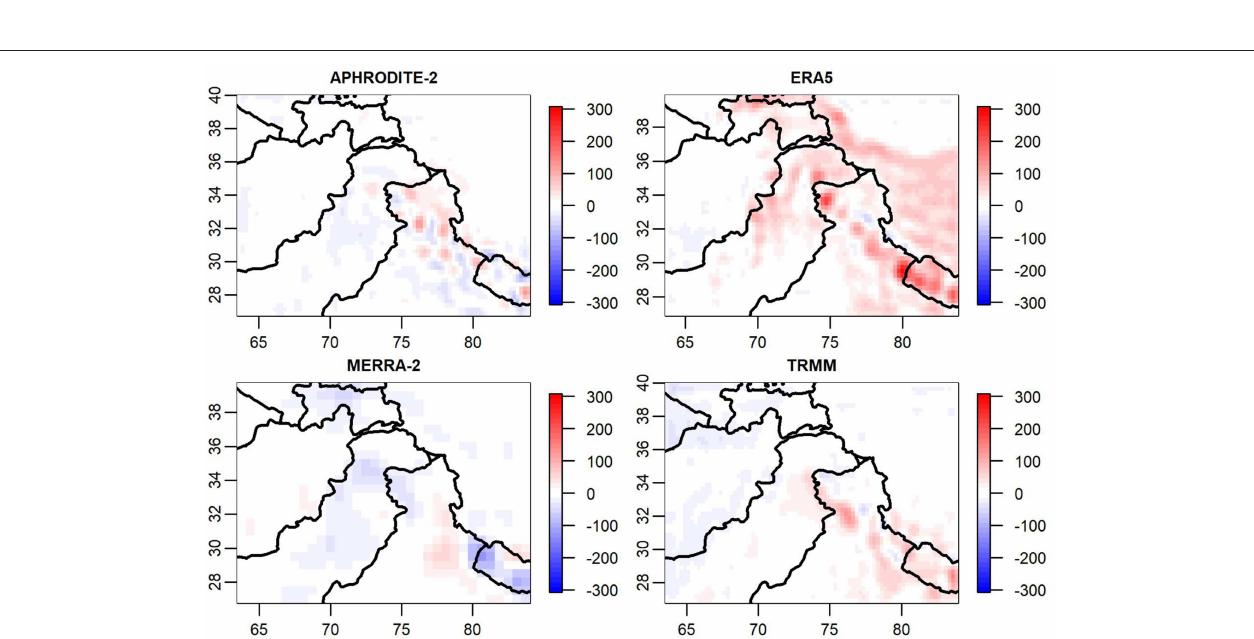
FIGURE 9 | Averaged discrepancies (in mm) for the months of June, July, and August across 10